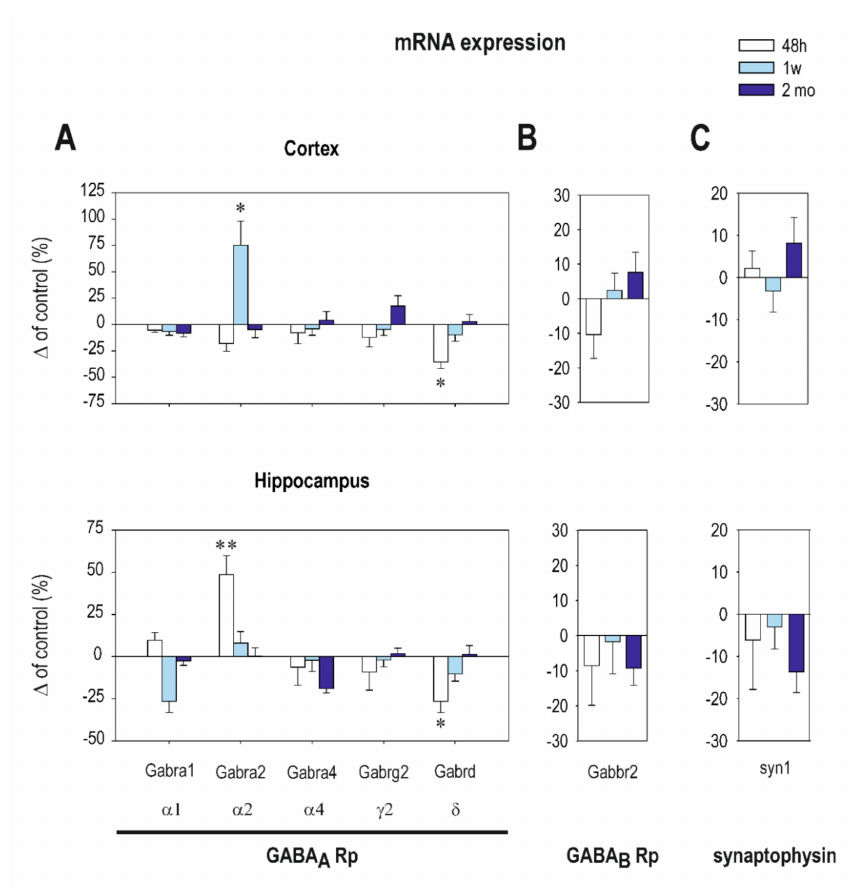
Figure 1. The transcription levels of the Gama aminobutyric acid A (GABA A ) receptor subunits ( A ) and the GABA B receptor subunit ( B ) in the cortex (on the top) and in the hippocampus (on the bottom) at three intervals after clonazepam (CZP) cessation (48 h, 1 week, and 2 months—legend at the top). ( C ) The graphs on the right demonstrate the transcription levels of synaptophysin at the